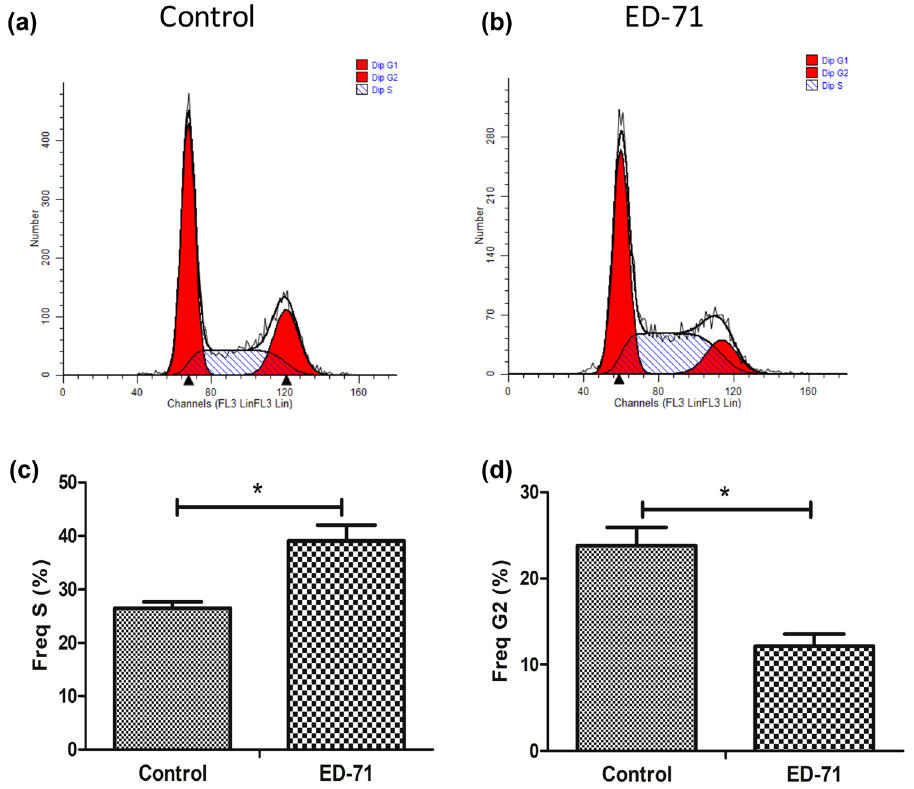
Figure 2: ED - 71 ( 0.5 nM ) markedly increased the percentage of liver cancer cells in S stage and decreased the percentage in G2 stage of the cell cycle. ( a ) Representative picture of cell cycle was measured without ED - 71 treatment; ( b ) representative picture of cell cycle was measured after treatment with ED - 71; ( c ) quanti fi cation analysis of cells in S stage after treatment with ED - 71; ( d ) quanti fi cation analysis of cells in G2 stage after treatment with ED - 71. * P < 0.05 compared with the control